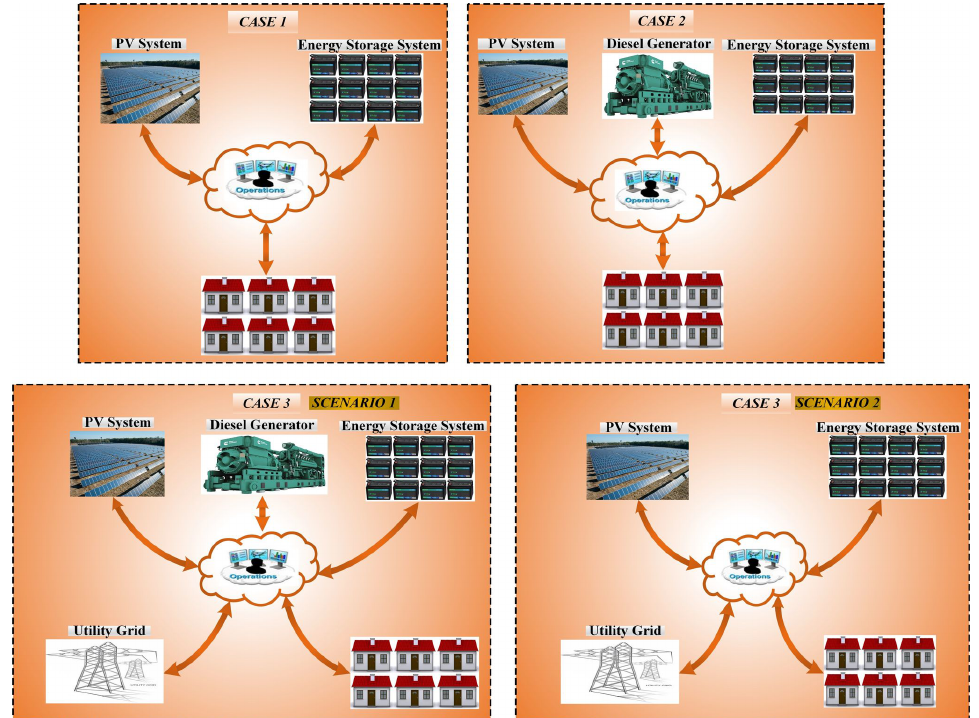
Figure 3. Schematic diagram of the proposed microgrid in three cases.